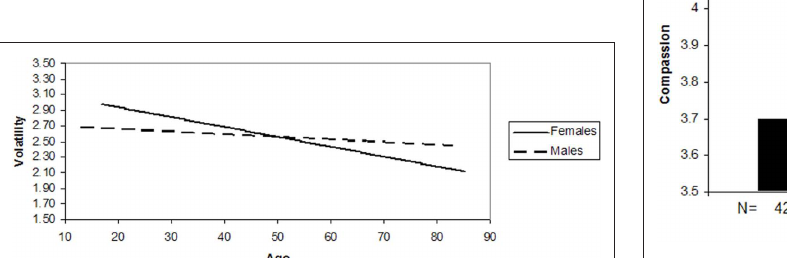
FIguRE 5 | Age moderates gender differences in Compassion.